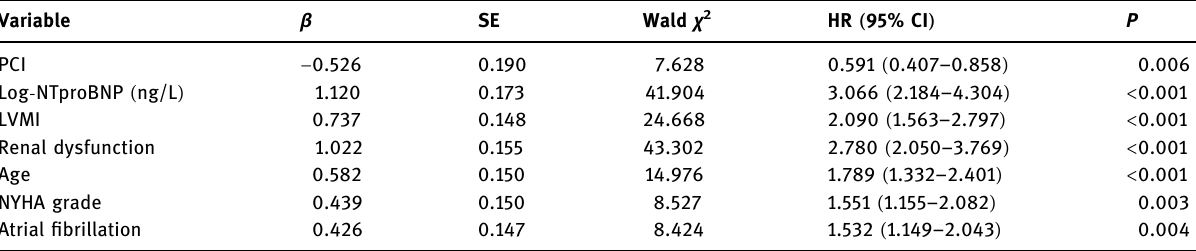
Table 3: Multivariate Cox regression